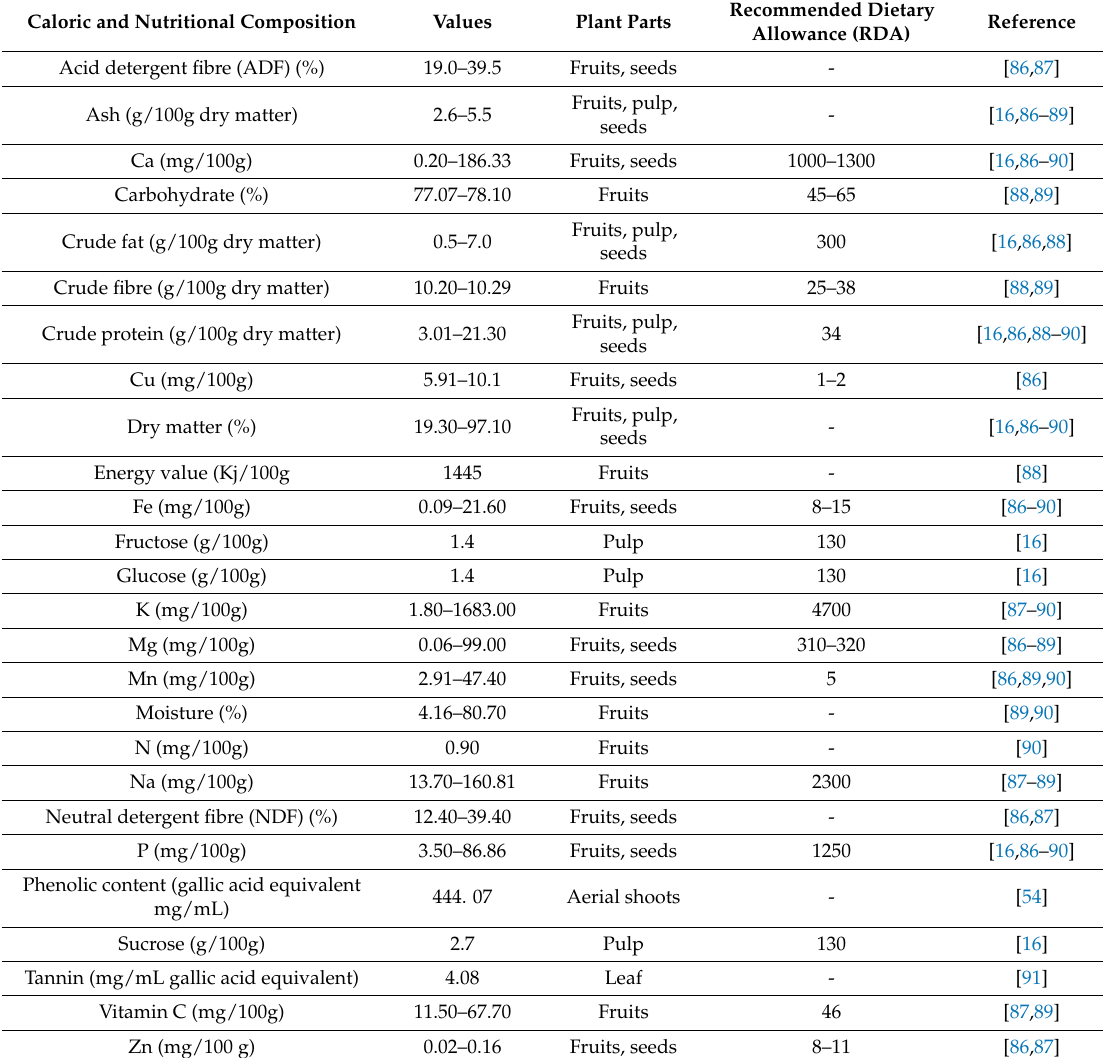
Table 3. Nutritional composition of fruits and other plant parts of Vangueria infausta subsp. infausta . Caloric and Nutritional